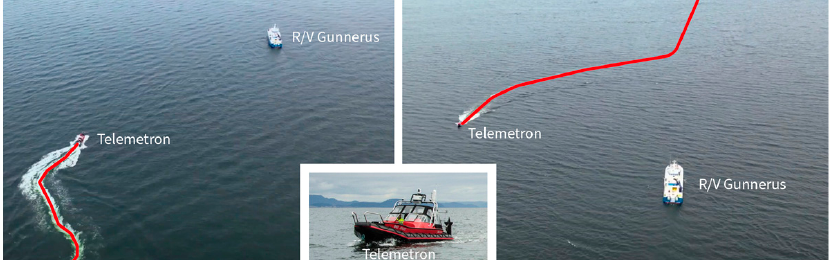
Figure 14. Collision avoidance of the ASV Telemetron: ( Left ) The vessel avoids collision, but the path is jagged, disjointed, and unpredictable. This undermines the trust of the crew, operators, passengers, and other vessels in the environment. ( Right ) Telemetron avoids collision with a smooth and predictable path. Crew, operators, passengers, and other vessels trust the autonomous